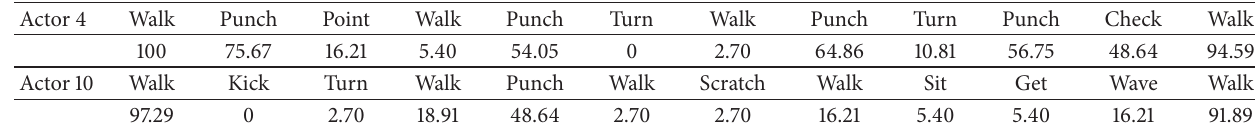
Table 5: Accuracy in % obtained in recognizing each